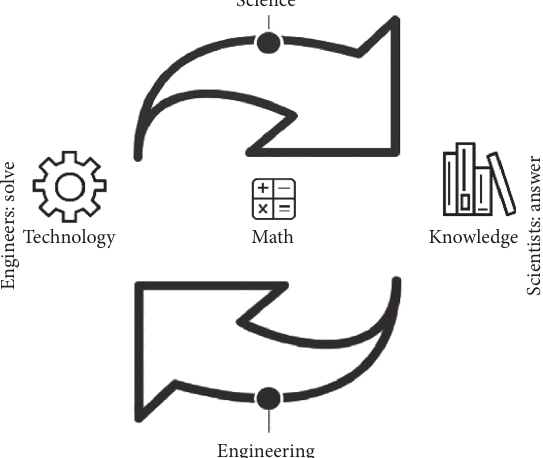
Figure 1: The STEM